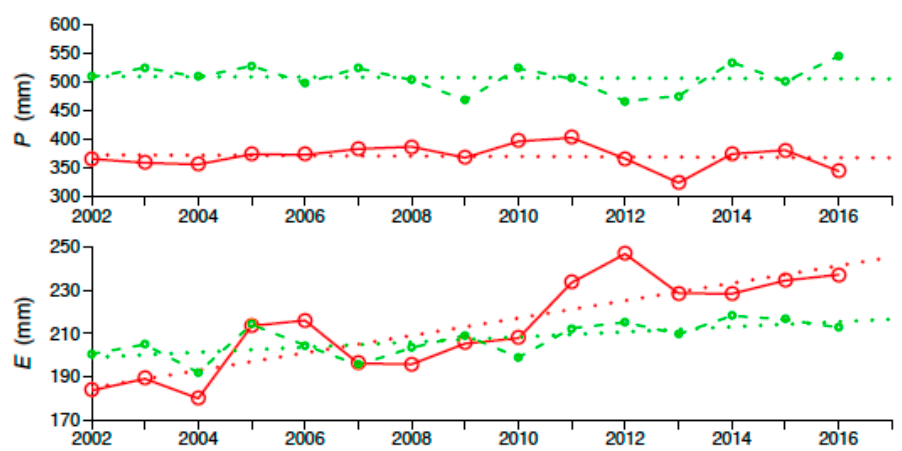
Figure 4. Temporal variations in the annual hydro-meteorological factors, namely, ( a ) the mean annual ( T aY ) and ( b ) mean JJA 2-m air temperature ( T aJJA ), ( c ) P , and ( d ) E , of the Arctic circumpolar tundra region from 2002 to 2016. Dotted lines denote the linear regression lines for each colored element.